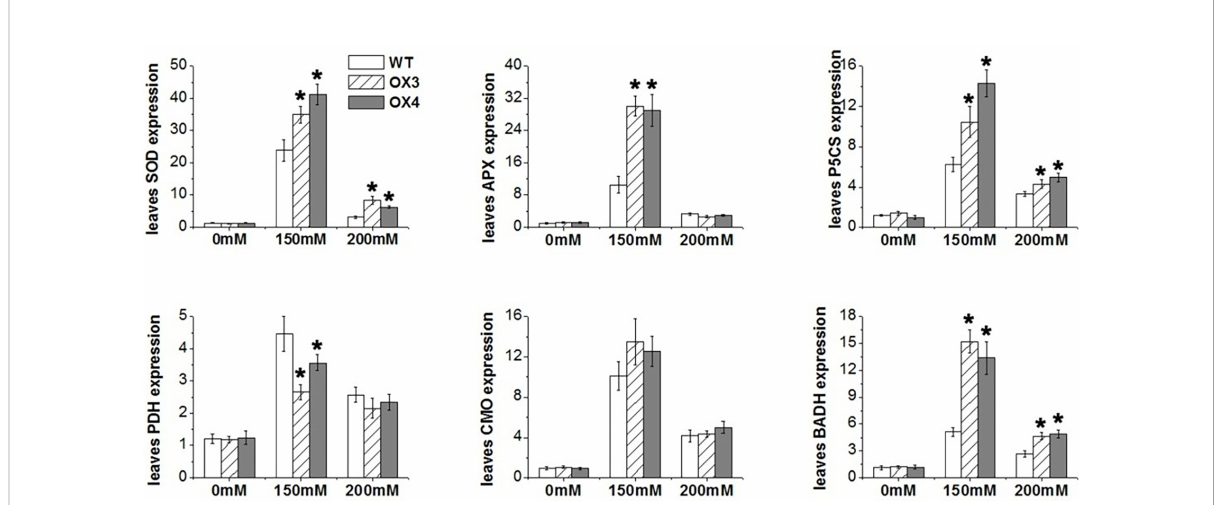
FIGURE 10 The relative expression of genes regulating antioxidant enzyme and osmolytes in Arabidopsis under salt stress. ZmGnTL -OX plants and WT were treated with 0 mM, 150 mM, and 200 mM NaCl for 48 h. Data are shown as means ± SE of fi ve biological replicates, and * indicated statistical signi fi cance at *P<